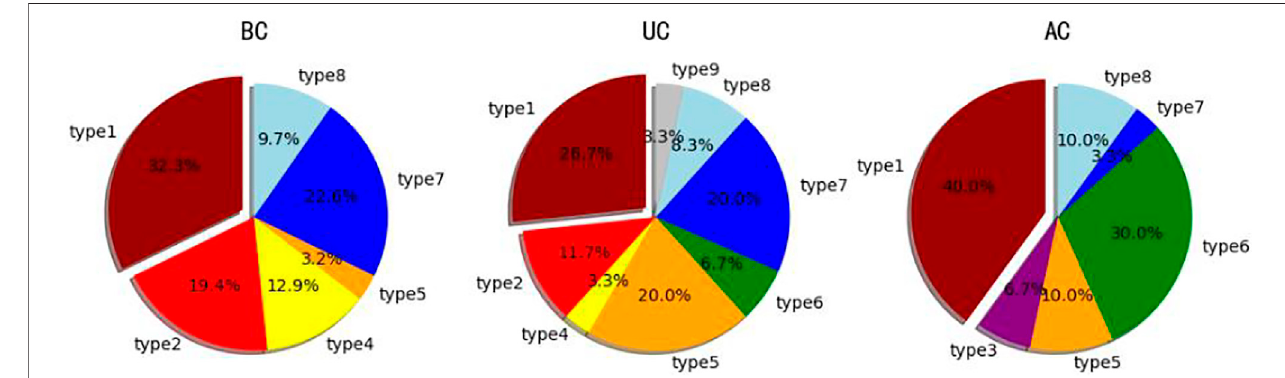
FIGURE 8 | Proportion of the nine circulation types in the BC, UC, and AC stages.